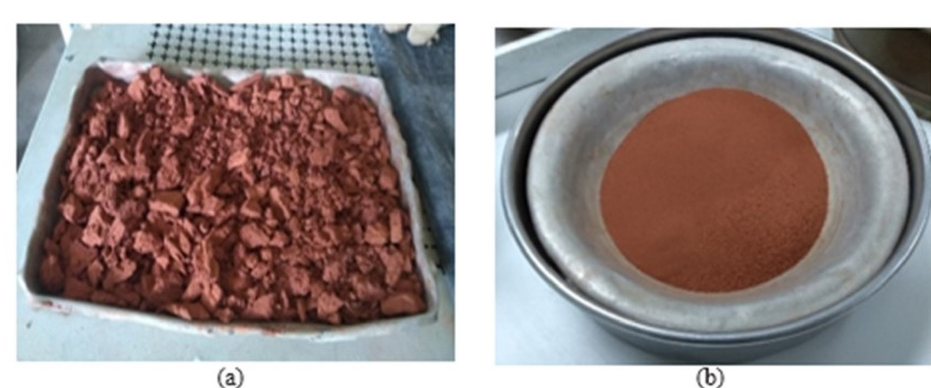
Figure 1. (a) Red mud residue before comminution and (b) after hand sieving through a 100